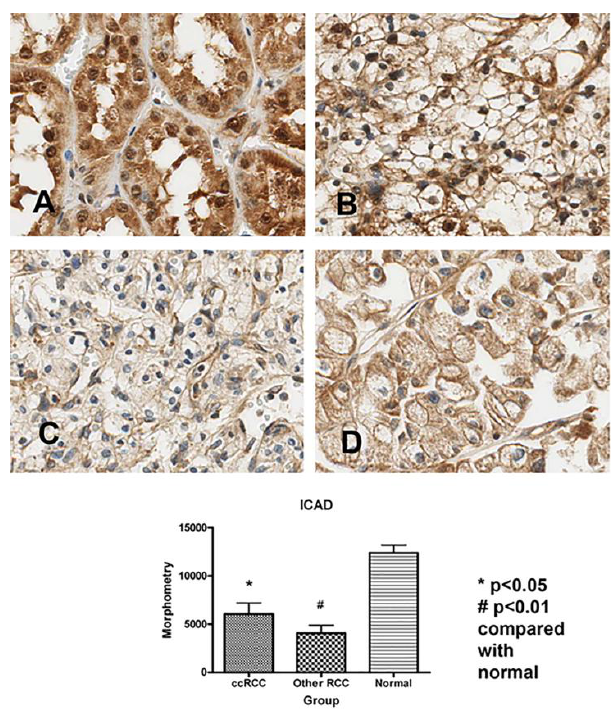
Figure 2. ICAD protein expression and morphometry in normal kidney versus RCCs. ICAD had very strong expression in the normal kidney ( A ), especially in the proximal tubular epithelium. Although clear cell RCC also had relatively strong expression ( B ), it was significantly reduced compared with normal tissue (p < 0.05). Likewise, other subtypes of RCC ( C and D illustrate chromophobe and papillary, respectively) had significantly lower expression than that seen in the normal tissue (p < 0.01). There was some nuclear localisation in clear cell RCC ( B ), but in general no nuclear localisation was seen in other RCC subtypes ( C and D ). The morphometry results from the Image-Pro Plus software analyses for clear cell RCC versus all other non-clear cell RCC subtypes are plotted below the IHC. Expression (pixels) in all RCCs was significantly lower than that seen in the normal tissue. There was no significant difference in expression between clear cell RCC and all other RCC